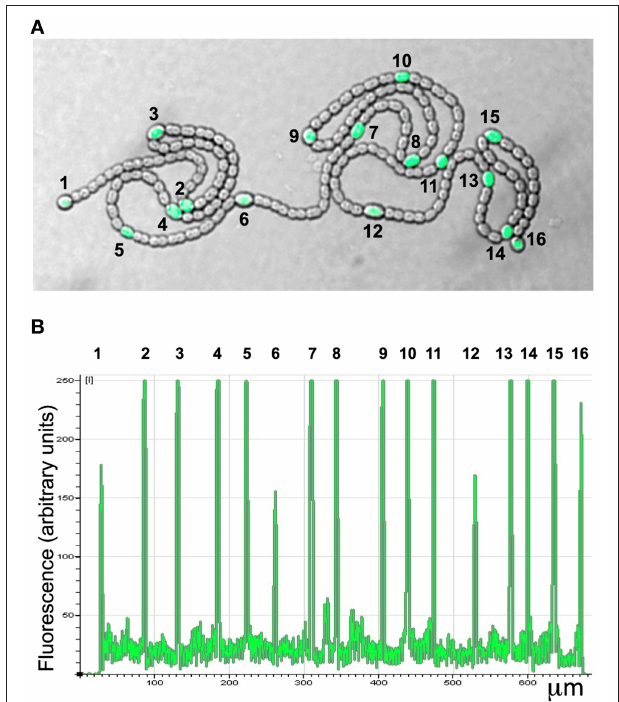
FIGURE 6 | Expression of P nsiR8 - gfp in nitrogen-fixing filaments of Nostoc sp. PCC 7120. (A) Confocal fluorescence image of a filament growing on top of nitrogen-free medium. The green (green fluorescent protein) and bright field channels are merged. (B) Quantification of the green signal along the filament shown in (A) . The position of heterocysts is indicated with numbers.